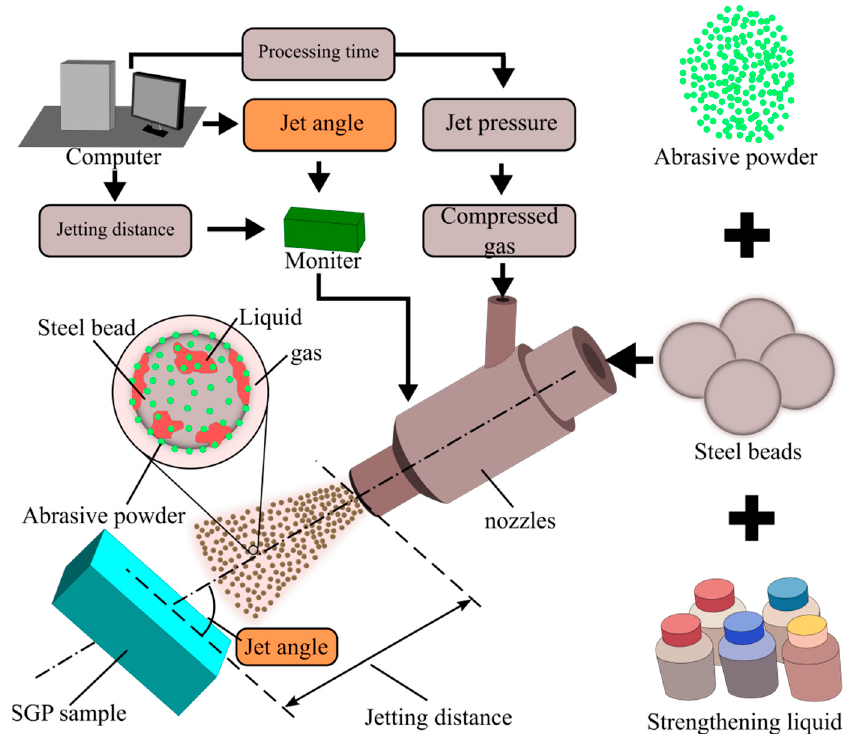
Figure 2. Parameter setting and treatment process of SGP.